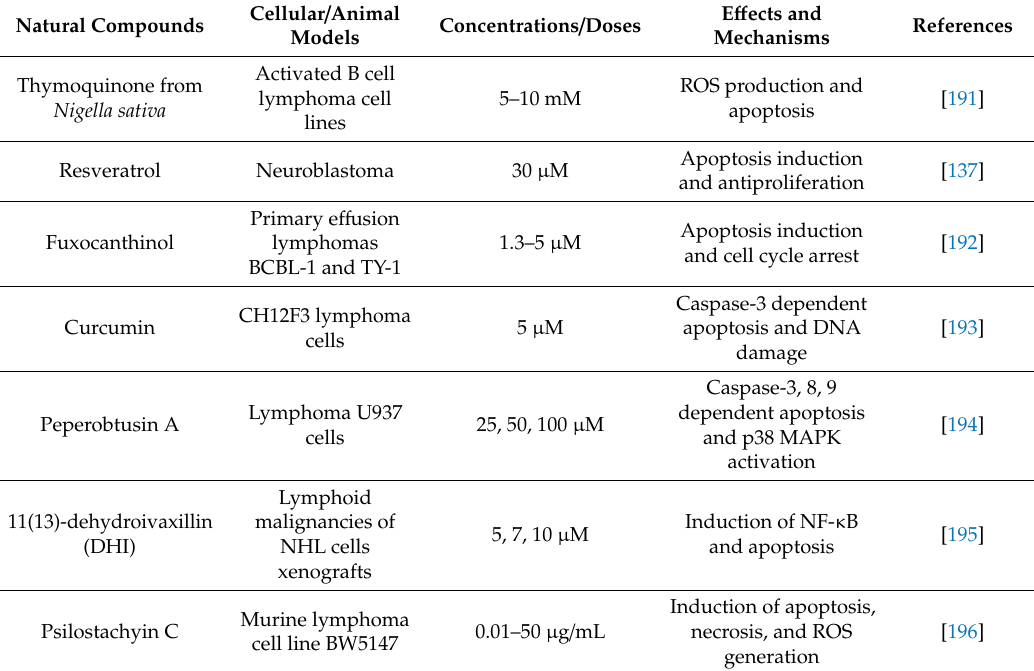
Table 2. Anticancer e ff ects of natural cancers in the management of lymphomas. Natural